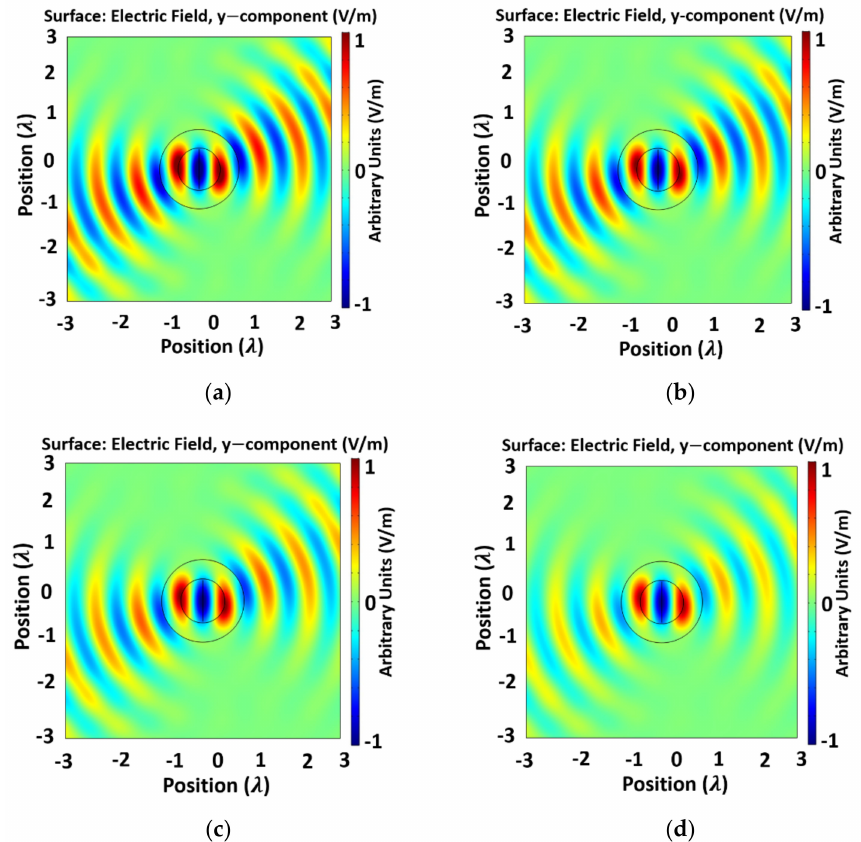
Figure 7. The electric fields for the proposed TO-based single element beam-steerer for different values of loss factor (tan δ ): ( a ) tan δ = 0.0; ( b ) tan δ = 0.01; ( c ) tan δ = 0.1; ( d ) tan δ =